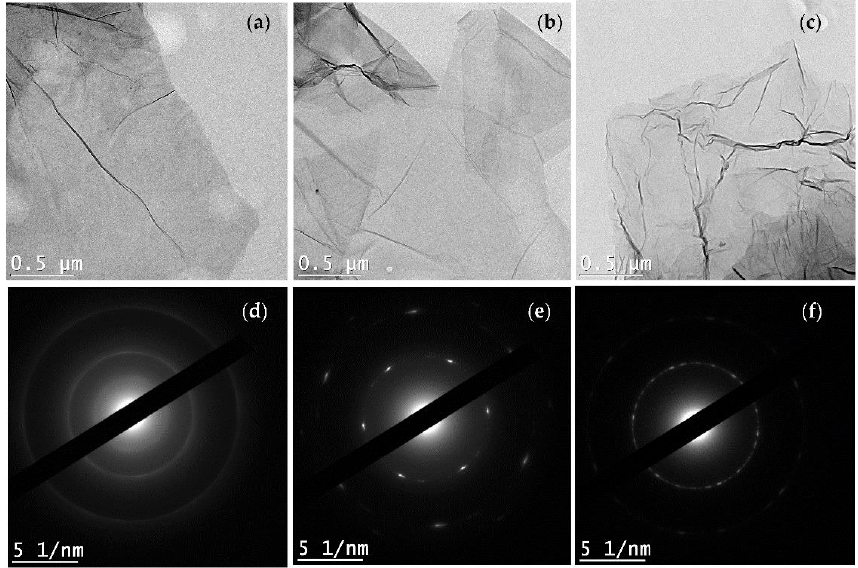
Figure 5. TEM images of ( a ) GO; ( b ) rGO and ( c ) Am-rGO with ( d – f ), respective SAED pattern.